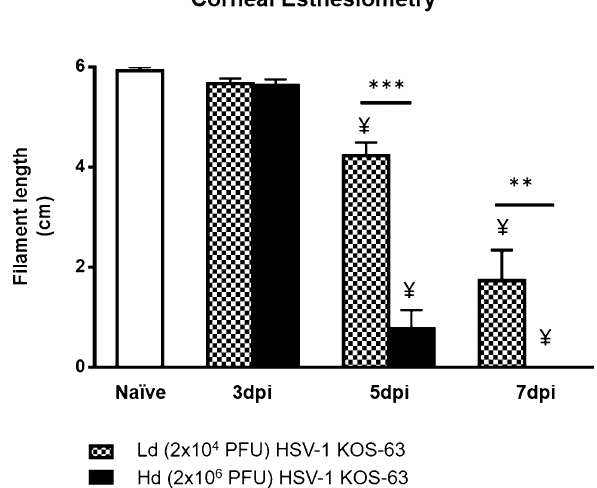
Figure 7. Corneal esthesiometry results. Corneal sensitivity was measured using Cochet-Bonnet esthesiometer in the central corneas. Maximum filament length is 6 cm and indicates full sensitivity. Corneal nerve sensitivity was significantly decreased after 5 dpi in both low dose (Ld) and high dose (Hd) HSV-1 KOS-63-infected corneas as compared to naïve corneas. Bars are showing mean ± SEM. p values are calculated by